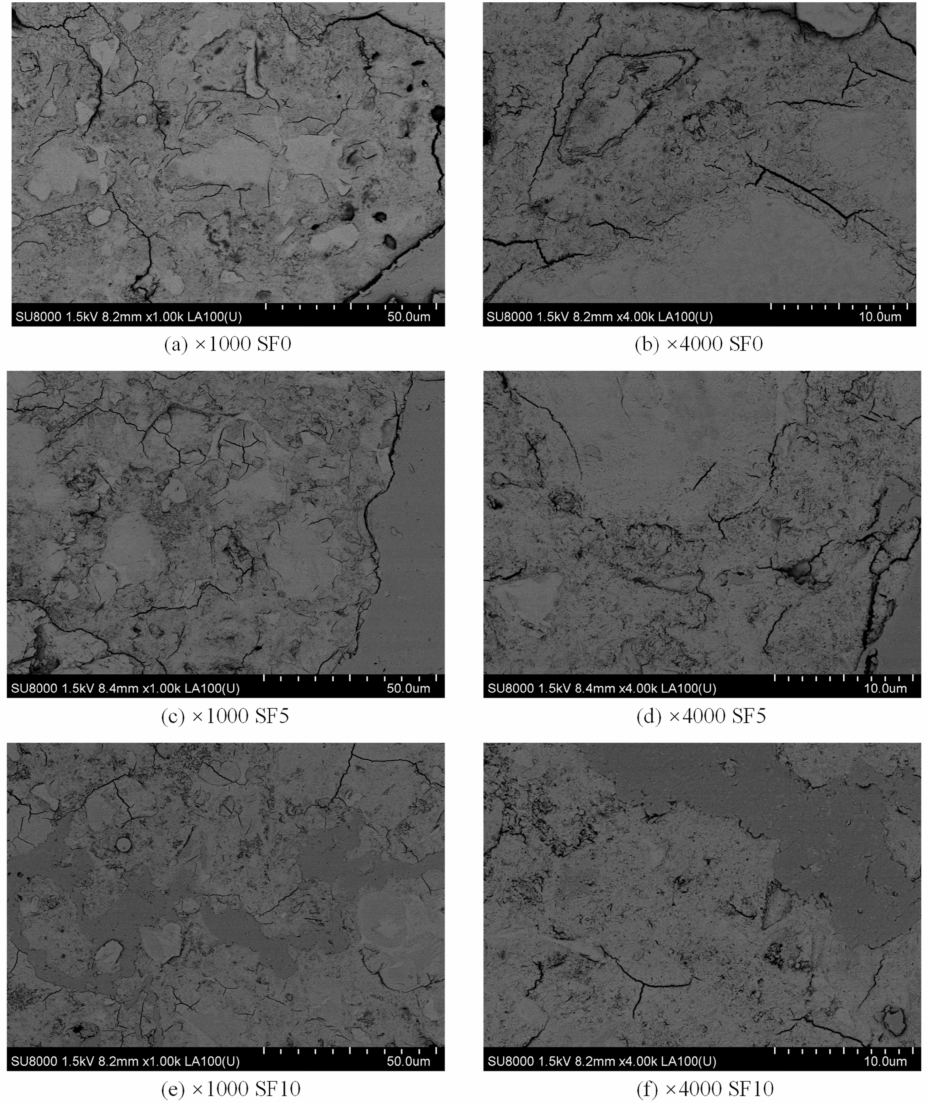
Figure 3. BSE images of mortar samples with different magnifications (1000 times and 4000 times). ( a ) sample SF0 with 1000 times magnification; ( b ) sample SF0 with 4000 times magnifi- cation; ( c ) sample SF5 with 1000 times magnification; ( d ) sample SF5 with 4000 times magnification; ( e ) sample SF10 with 1000 times magnification; ( f ) sample SF10 with 4000 times